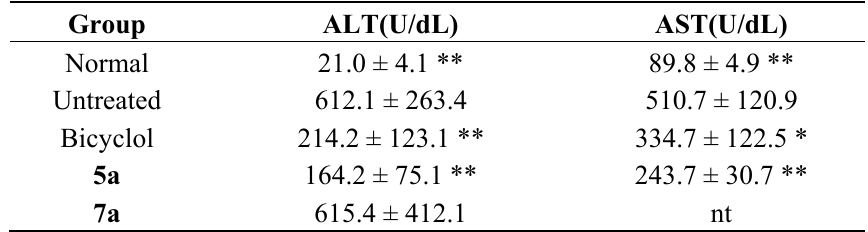
Table 1. Effects of Bicyclol, 5a and 7a on ConA-induced liver injury in